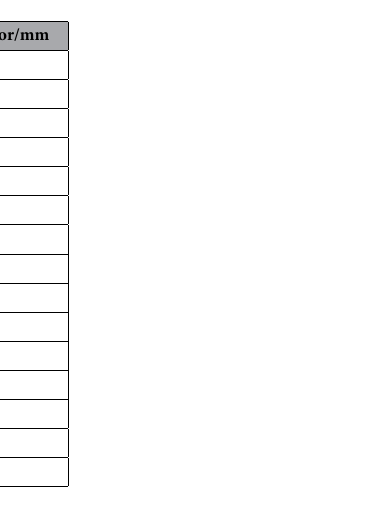
Table 2. Results of the location and absolute error of